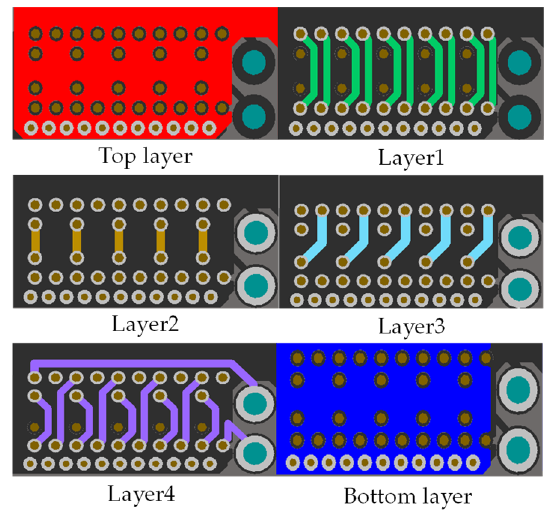
Figure 9. PCB-embedded spiral pattern pick-up coil configuration.